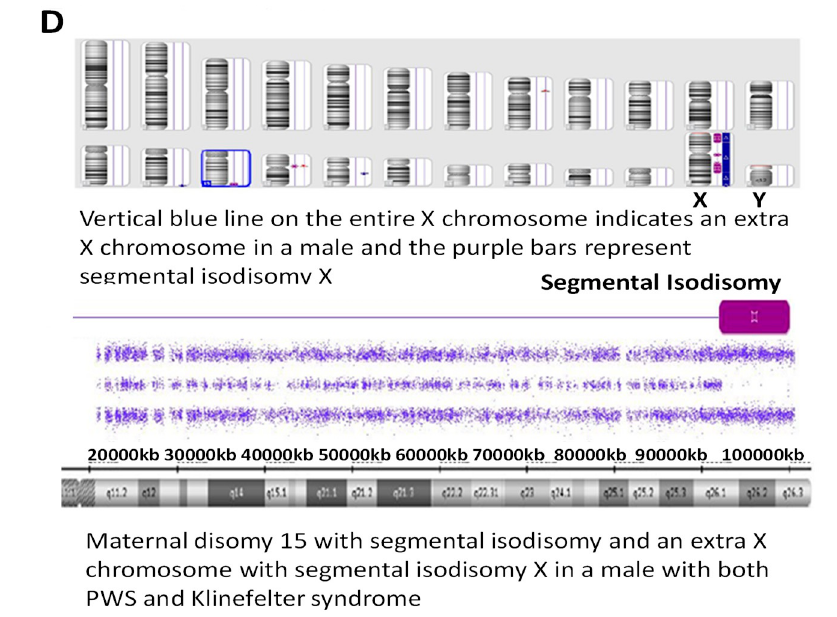
Figure 2. High-resolution chromosome microarray results showing examples of maternal disomy 15 in four PWS participants ( A – D ). Segmental isodisomy 15 is represented by segments of loss of heterozygosity as a purple-colored bar and found in ( A , D ) while total isodisomy 15 is seen in ( B ). Maternal heterodisomy 15 is shown in ( C ) with no loss of heterozygosity. ( D ) represents a PWS participant with segmental isodisomy 15 and segmental isodisomy X but with an extra X chromosome indicating the presence of Klinefelter syndrome, as well.